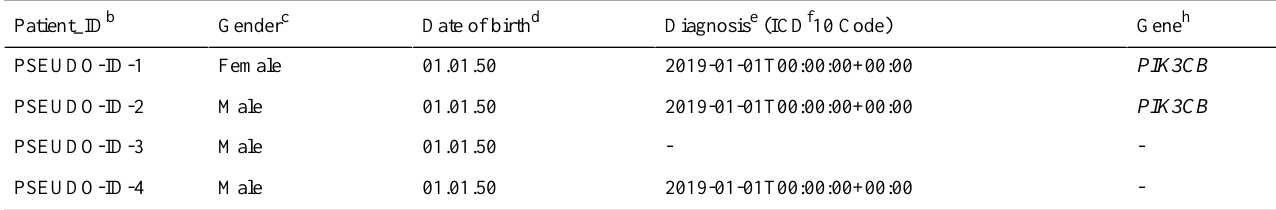
Table 4. Format of the initial raw data set.